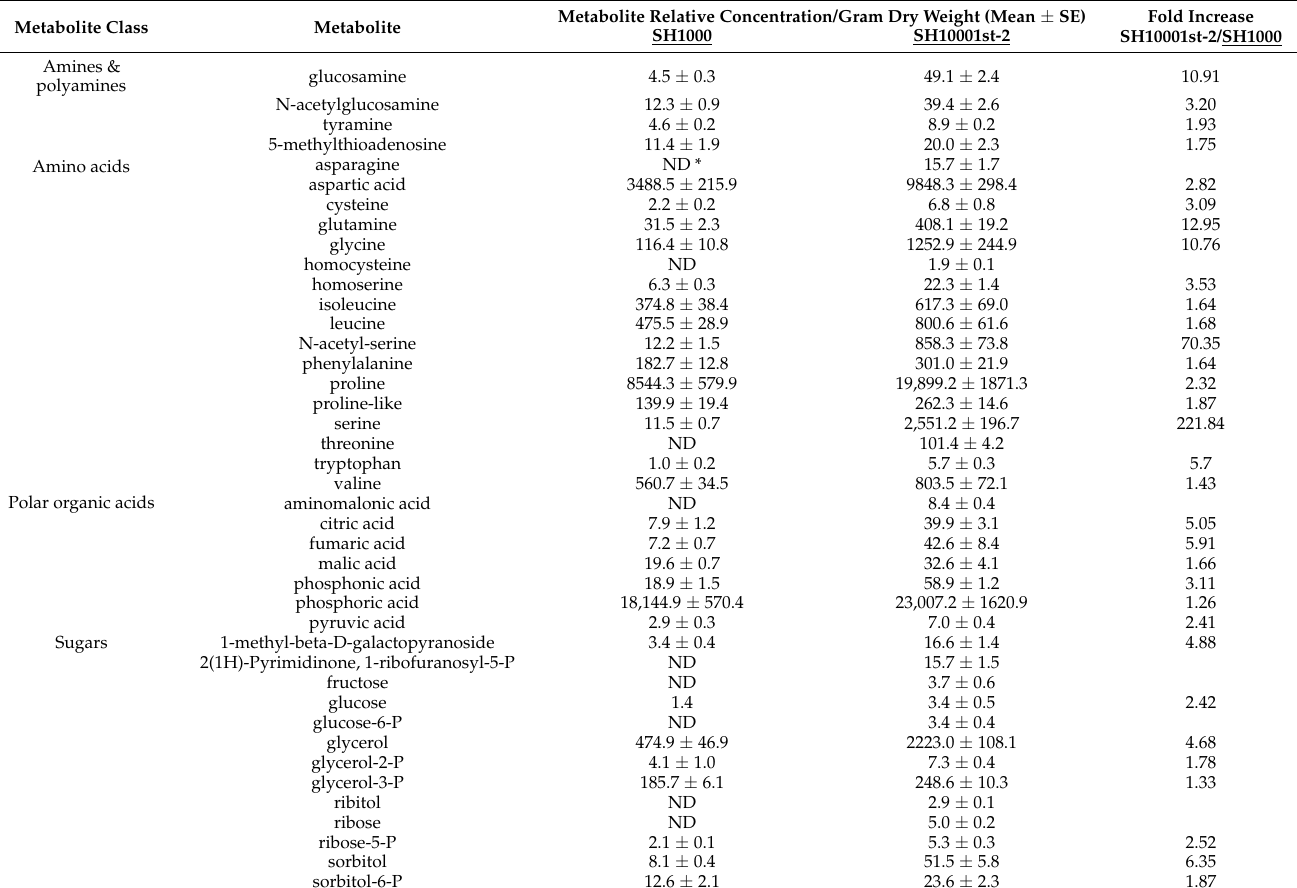
Table 6. Metabolites increased ( p ≤ 0.05) in SH10001st-2 compared to SH1000.